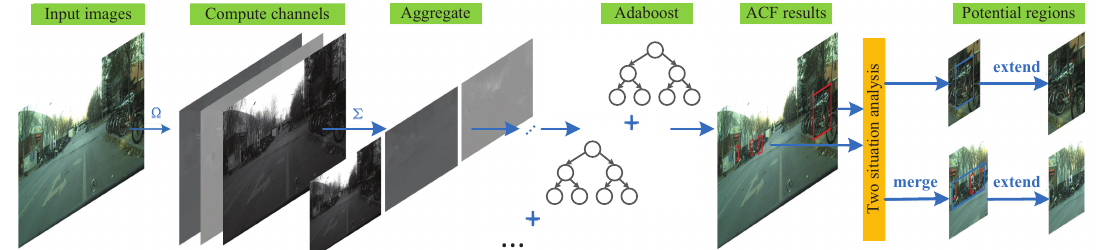
Figure 2. Structure for ACF-PR region proposal method. To get potential regions, ACF detector first gets preliminary bounding boxes. Then these bounding boxes are divided into two cases according to their position for different processes; lastly, potential regions are